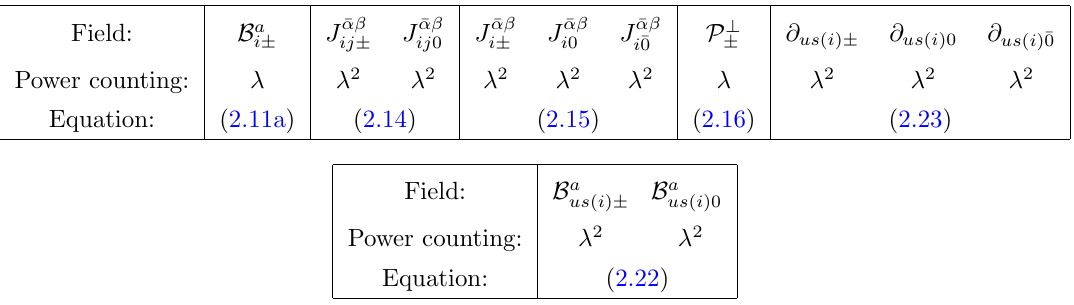
Table 1 . The helicity building blocks in SCET together with their power counting order in the I (cid:21) -expansion, and the equation numbers where their de(cid:12)nitions may be found. The building blocks also include the conjugate currents J in cases where they are distinct from the ones y